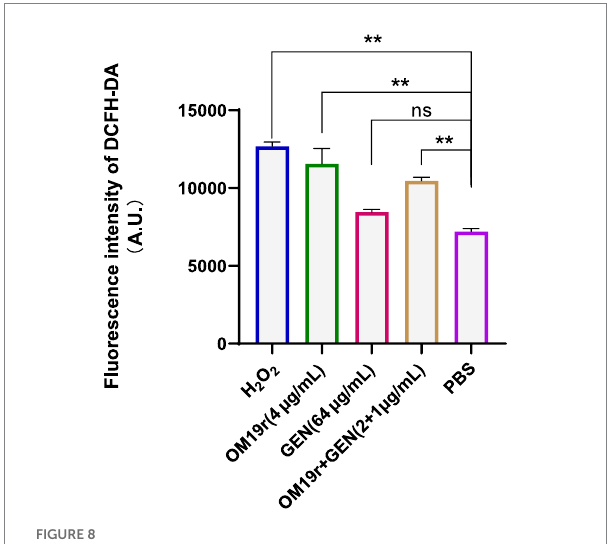
FIGURE 8 ROS accumulation in E. coli B2 cells determined by DCFH-DA fluorescent probe. Graphs show mean of three biological replicates, p-values were determined using an unpaired two-tailed Student’s t